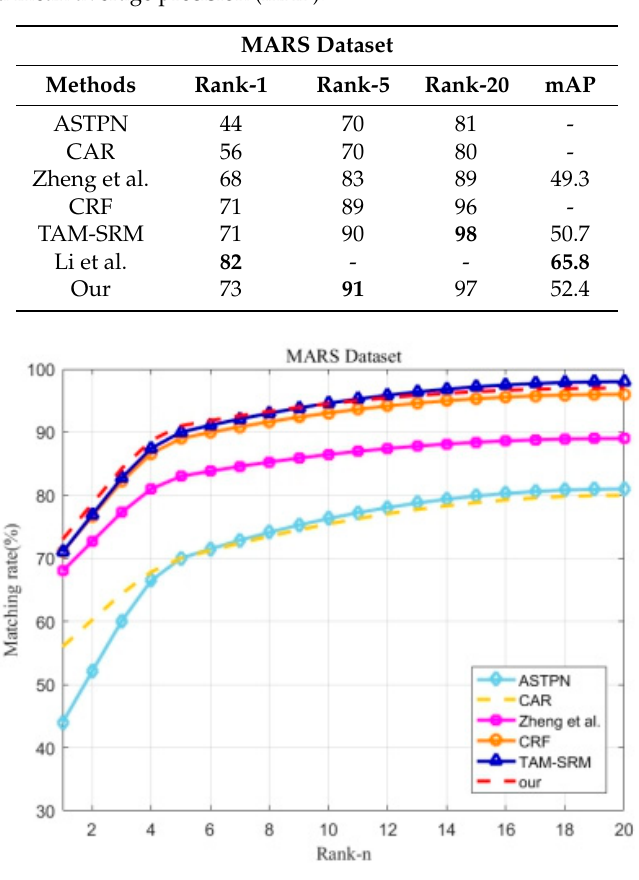
Figure 9. Experimental results of the comparison with other state-of-the-art algorithms for the MARS dataset in term of the CMC curve. Because the work of Li et al. [46] only reported the Rank-1 value, their results cannot be drawn as a